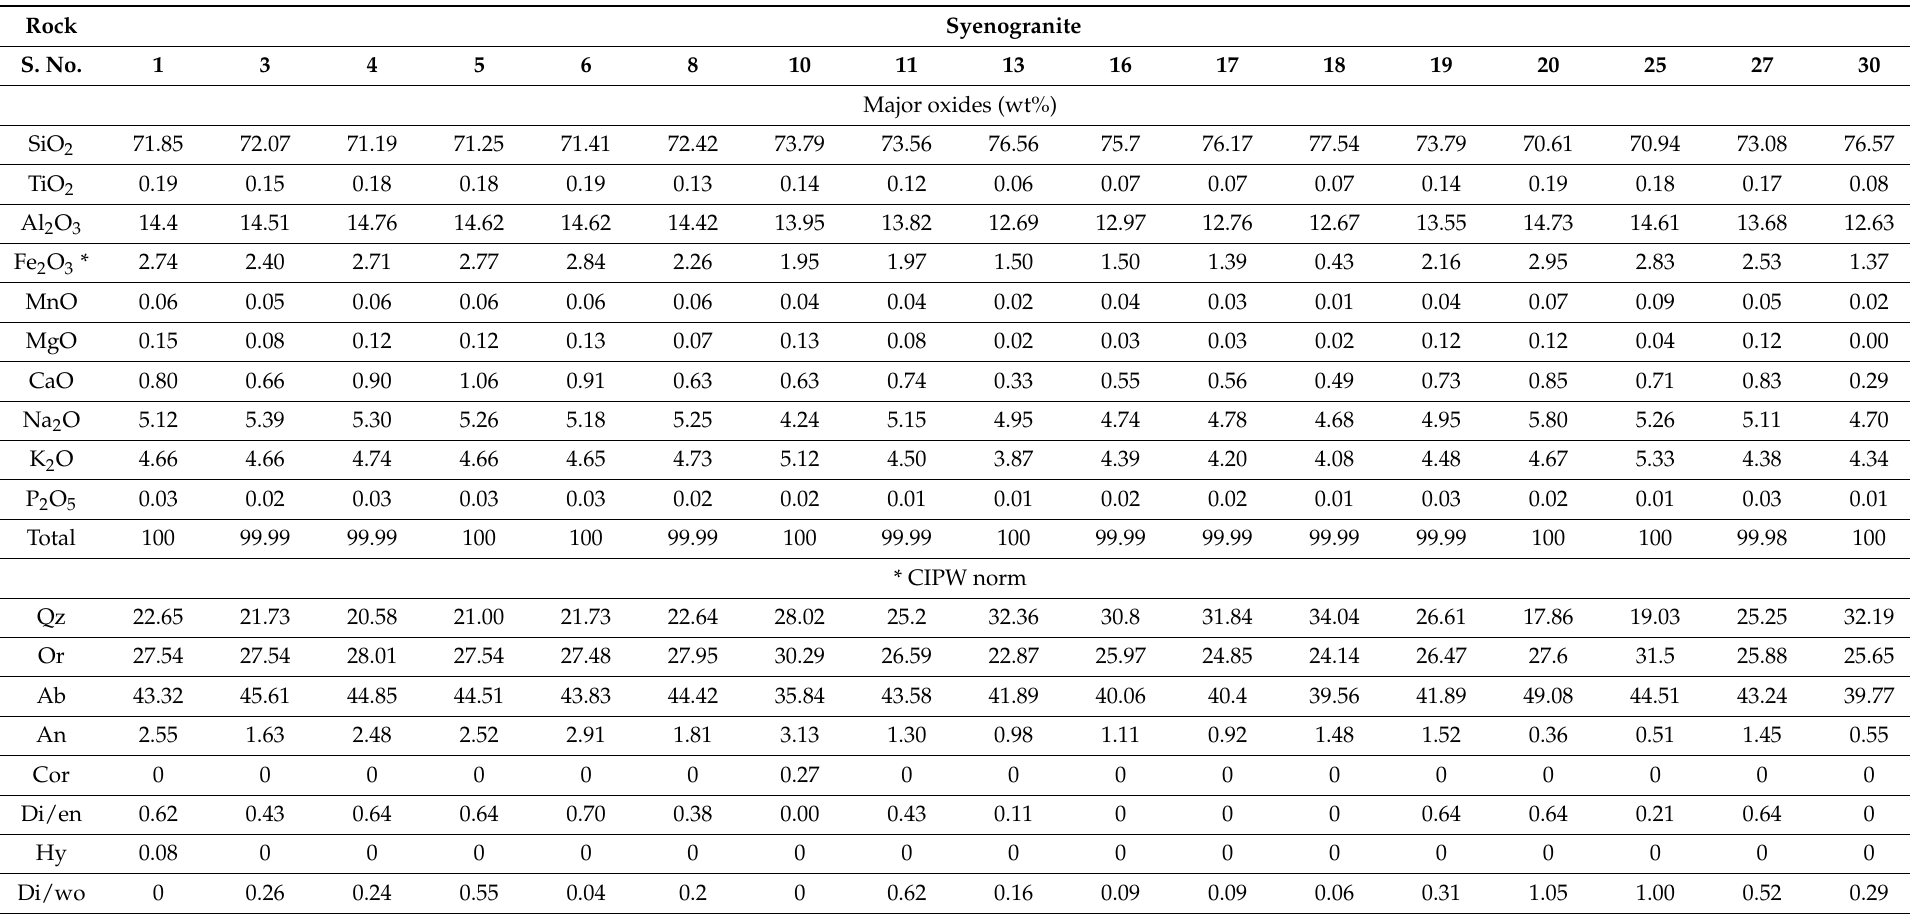
Table 2. Representative chemical (XRF) analyses of the Nikeiba granitoids, Southeastern Desert, Egypt. (Fe 2 O 3 * total iron as ferric iron oxide.) For locations of sample sites refer to Figure